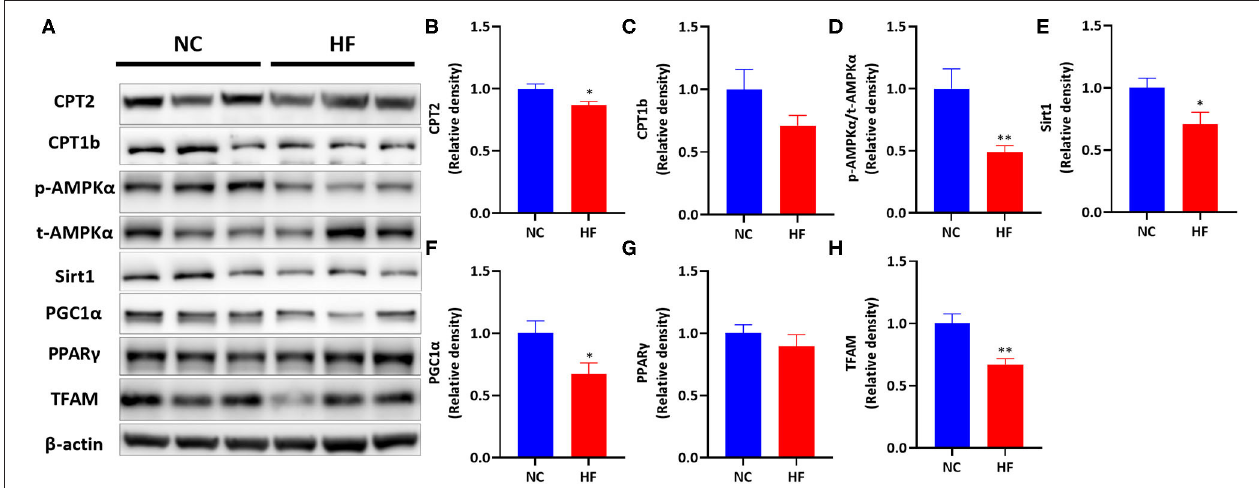
FIGURE 4 | HF feeding reduced protein expression of placental FAO by suppressing the AMPK signaling pathway. (A) Bands’ representative images of (B–G) . (B) CPT2; (C) CPT1b; (D) p-AMPK α /t-AMPK α ; (E) Sirt1; (F) PGC1 α ; (G) PPAR γ ; (H) TFAM. Data represented as the mean ± SEM. (NC, n = 5–6; HF, n = 6–7). * p < 0.05, ** p < 0.01, vs. NC. NC, normal chow diet; HF, high-fat diet; AMPK α , AMP-activated protein kinase α ; Sirt1, sirtuin 1; PGC1 α , peroxisome proliferator-activated receptor gamma coactivator 1-alpha; PPAR γ , Peroxisome proliferator-activated receptor γ ; CPT1a, carnitine palmitoyltransferase 1a; CPT1b, carnitine